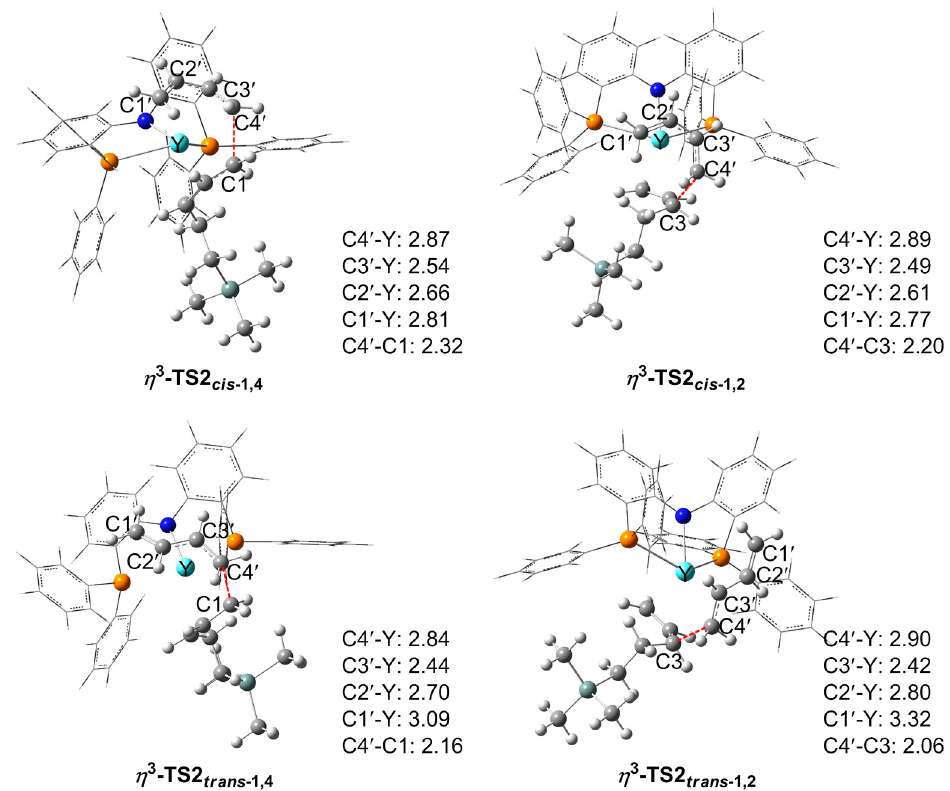
Figure 5. Transition state structures (distances in Å) for the cis - and trans -insertion of butadiene into the metal–allyl π -bond of the P1 cis .